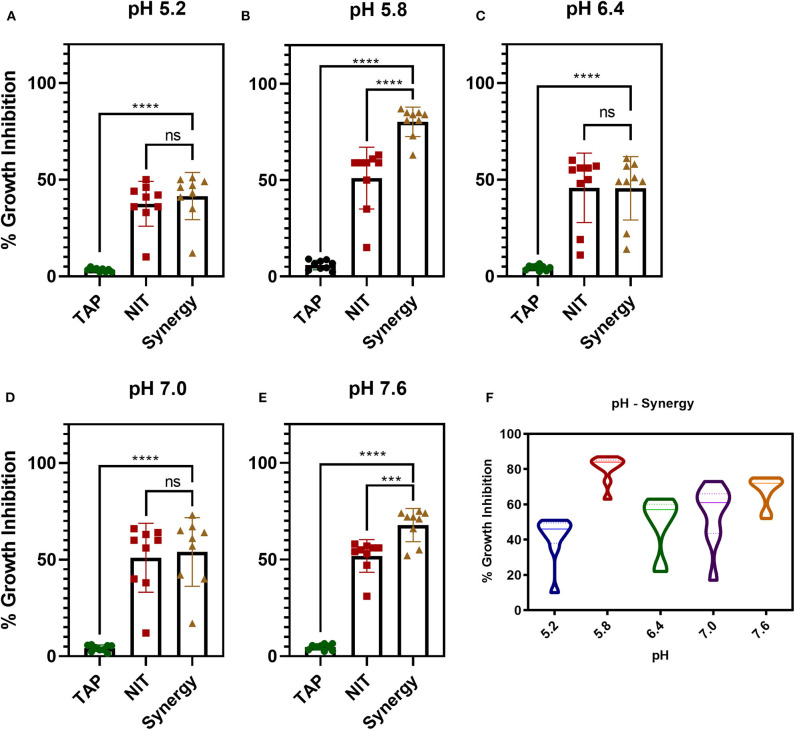
pH and time-dependent synergy activity of TAP and NIT. (A–E) shows the individual and synergy antibacterial action at the recorded concentrations of synergy activity. (A,B) the concentrations of TAP and NIT are 32 and 8 μg/mL, respectively. (C–E) the concentrations of TAP and NIT are 64 and 16 μg/mL, respectively. Student unpaired t-test was used for the significance analysis. p < 0.05 was considered significant. ***p = 0.002 and ****p ≤ 0.0001. (F) Shows the violin plot to depict the distribution of the synergy activity at different time points. At pH 5.8, the activity is maintained across all time points.